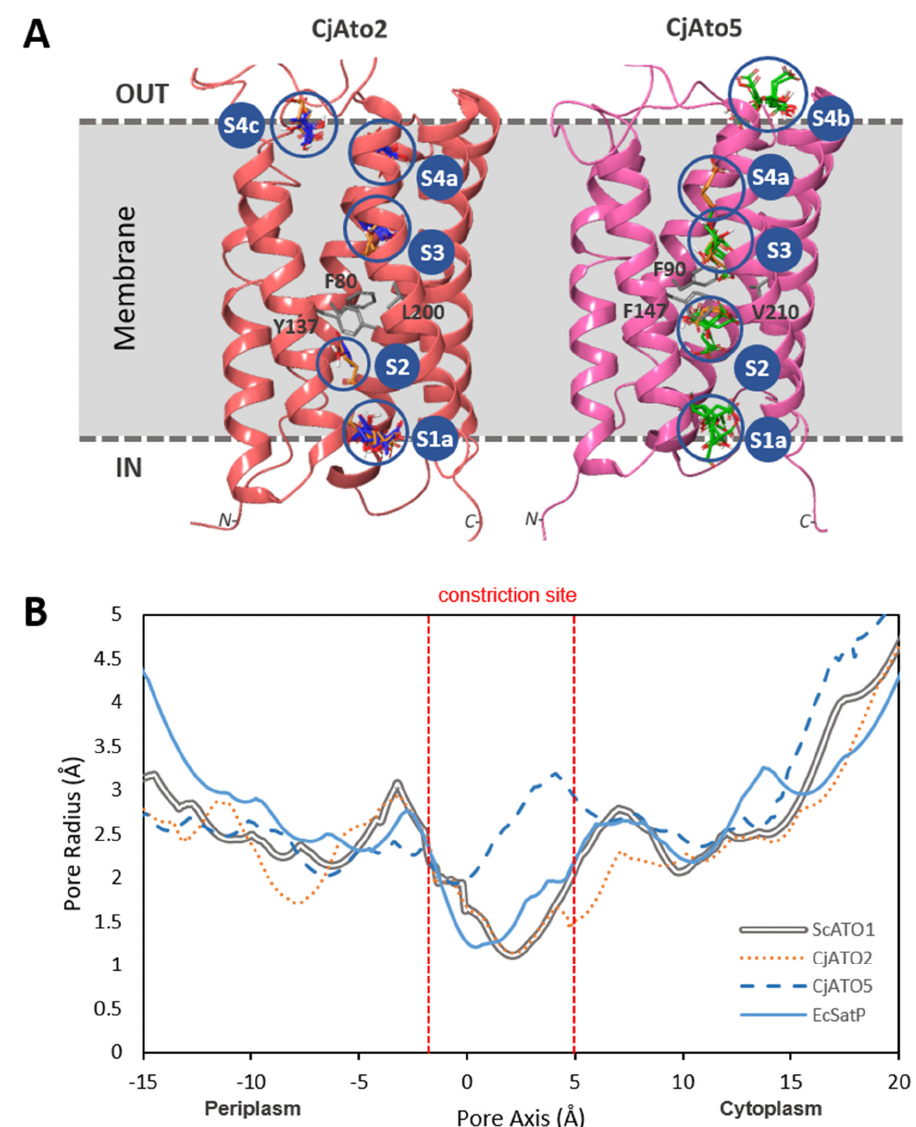
Figure 6. Predicted 3D structure of CjAto2 and CjAto5 transporters. ( A ) Molecular docking of CjAto2 and CjAto5 3D models based on SatP_Ck structure (PDB 5YS3) with the substrates lactate (blue ligand), succinate (orange ligand), and citrate (green ligand). The four binding sites (S1 − 4) described in SatP_Ck were also found in CjAto2 and CjAto5. The localization of N − and C-terminal of the proteins is depicted. ( B ) Simulations for the pore radius profiles through the channel axis in the ScAto1 (grey line), CjAto2 (orange dotted line), CjAto5 (dark blue dashed-line), and EcSatP (blue line) proteins. The core of the channel, where the constriction site was found, is delimited by the vertical dashed red